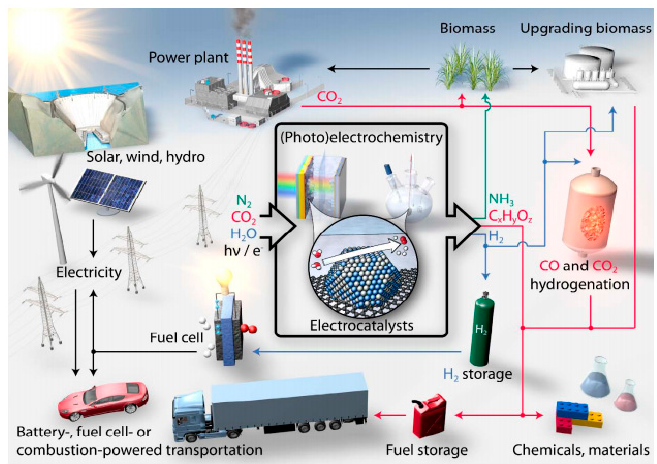
Figure 8. Sustainable energy future. Schematic of a sustainable energy landscape for the future based on electrocatalysis.